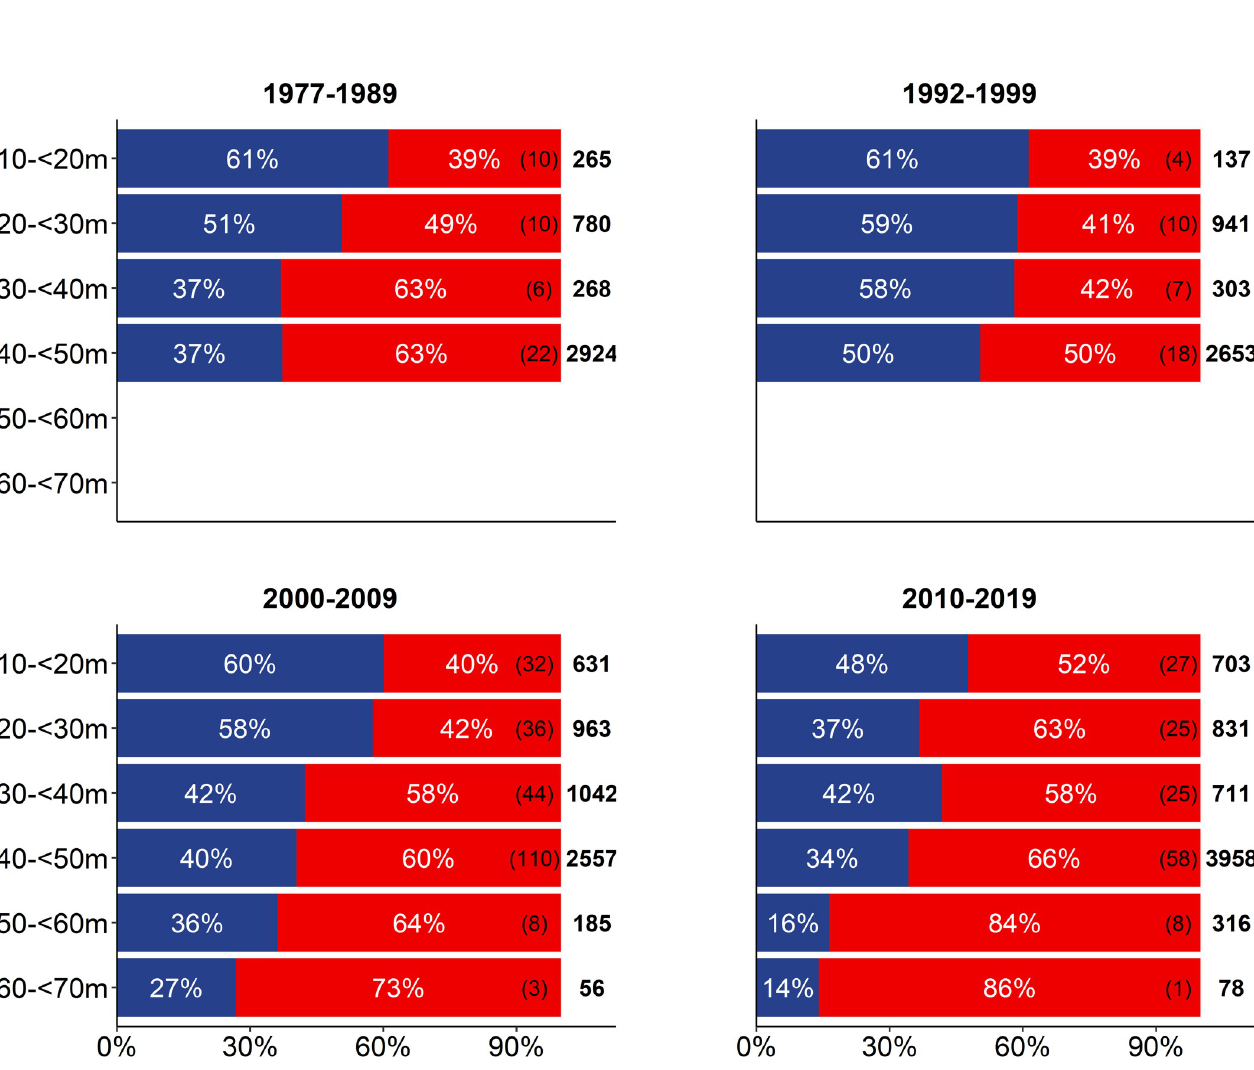
Fig 3. Depth-stratified distribution of stock mixing proportions in SD 24. Mixing proportions of WBC (blue) and EBC (red) are based on cod samples (N = 20 302) from trawl surveys between 1977 and 2019, grouped by capture depth and sampling decade. Total numbers of fishing hauls used in the stock mixing analysis (in brackets) and absolute numbers of otoliths used in the shape analysis (in bold) are given on the right side of each depth stratum. Depths without bars = no data available.